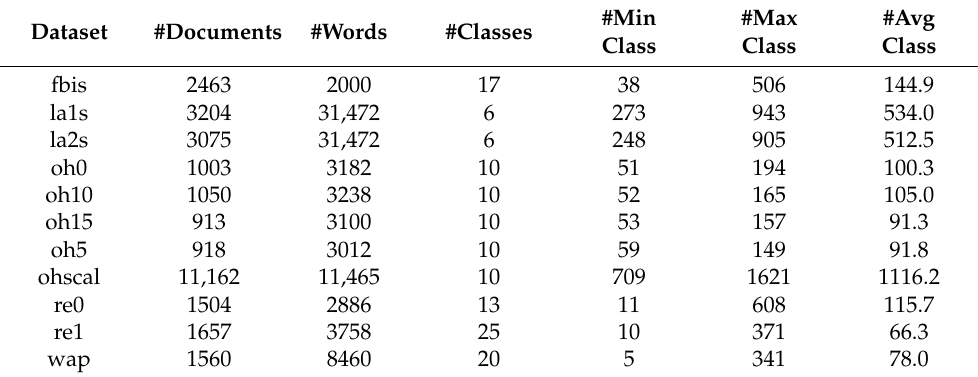
Table 1. Text classification datasets in our experiments.